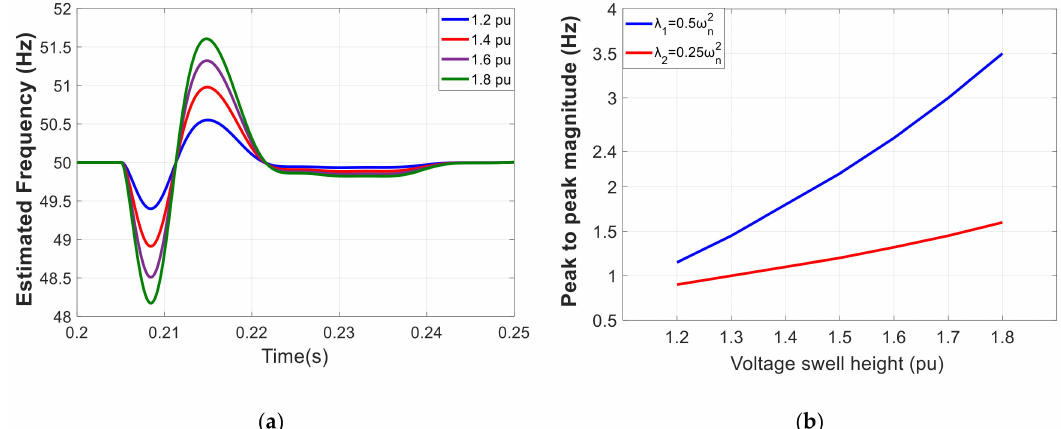
Figure 5. ( a ) Estimated frequency perturbations in the SOGI-FLL for different voltage sag swells ranging from 1.2 to 1.8 pu and FLL gain λ 1 = 0.5 ω 2 n . ( b ) Measured peak-to-peak maximum amplitude distortion in Hz, in blue for λ 1 = 0.5 ω 2 n , in red for λ 2 = 0.25 ω 2 n .